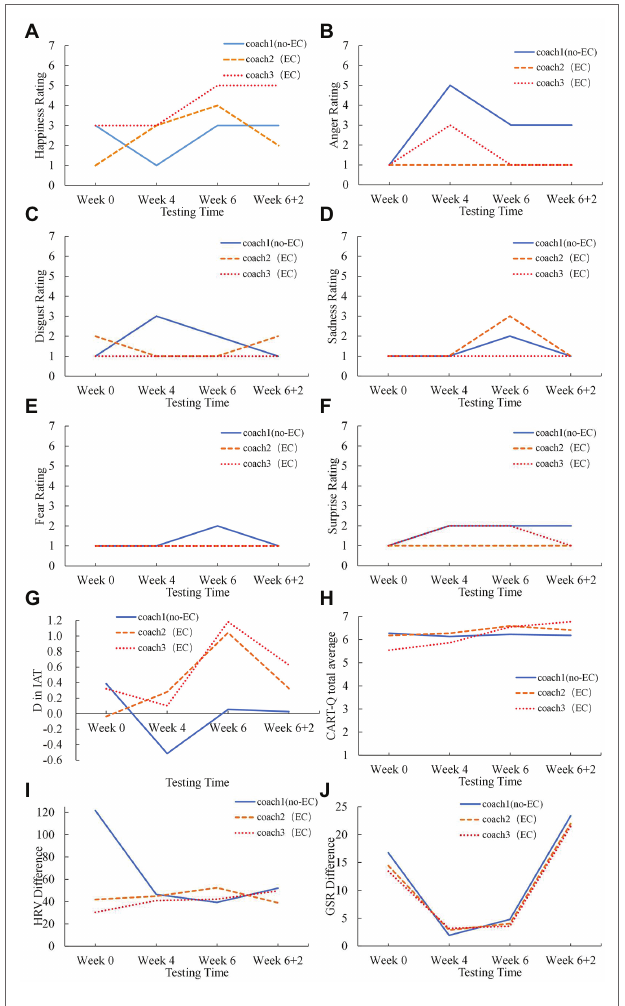
FIGURE 3 | The variation of Athlete 2’s (A–F) the emotion ratings (happiness, anger, disgust, sadness, fear, surprise), (G) the D score in IAT, (H) the CART-Q scores, (I) the HRV, and (J) the GSR with time for the coaches with and without EC.